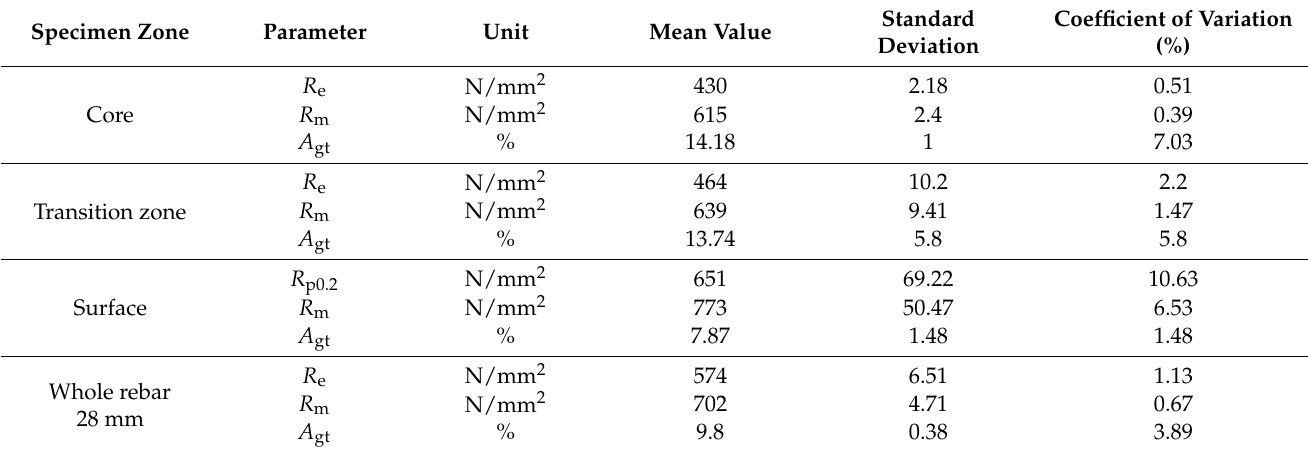
Table 5. Results of the tensile tests.